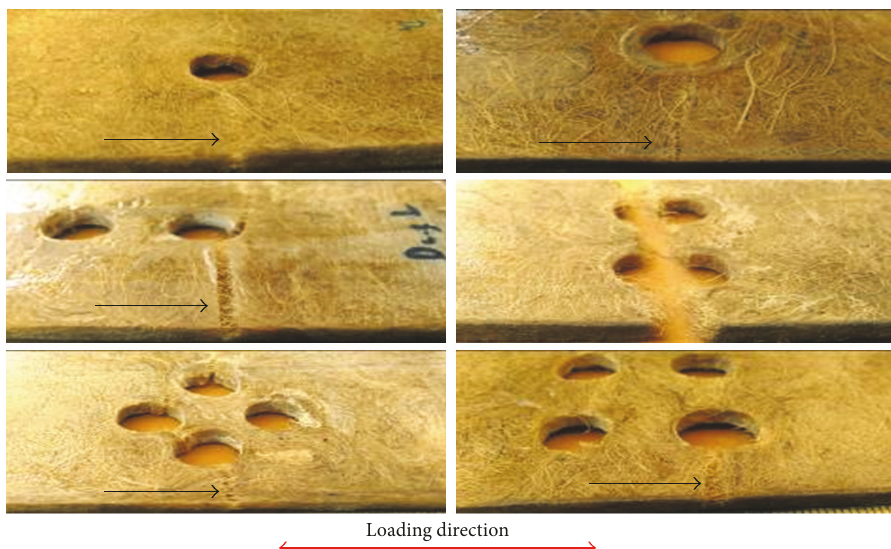
Figure 10: Macroscopic view of final failure form of lontar fiber-reinforced composites.